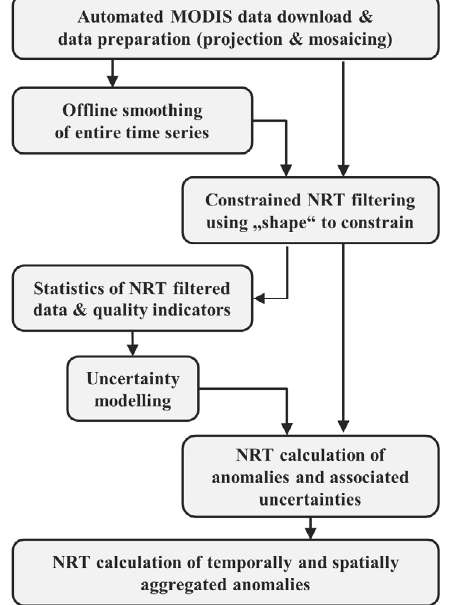
Figure 3: Principle of BOKU’s constrained near real-time (NRT) filtering. Black asterisks are the observed (raw) MODIS values from 16-day MVC (both Terra and Aqua). The blue line is the fitted curve of the (unconstrained) Whittaker smoother. The five coloured dots are the final (constrained)